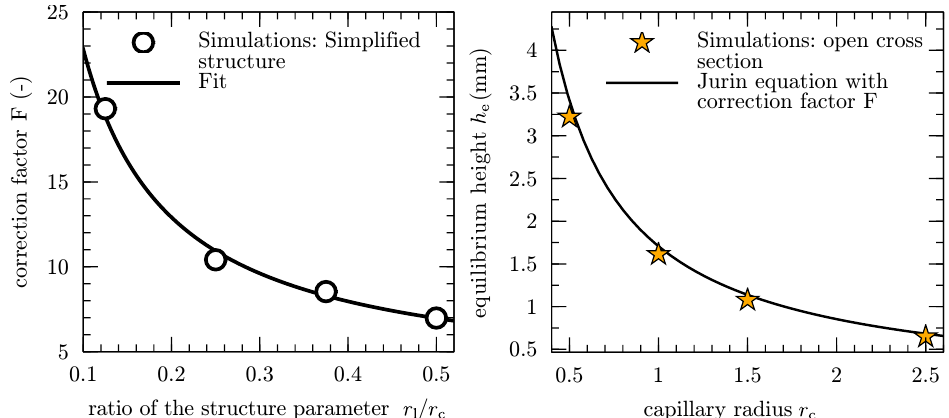
Figure 7. Derivation of an analytical correlation of the correction factor F , based on the simulation results (left, adapted from [6]) and equilibrium height h e , over ligament radius r c , for the open cross-sectional shape of Figure 6b. The right diagram shows the Jurin equation combined with the correction factor F and the simulations from Figure 5c. The simulation results are represented by star symbols, and the solid line follows Equation